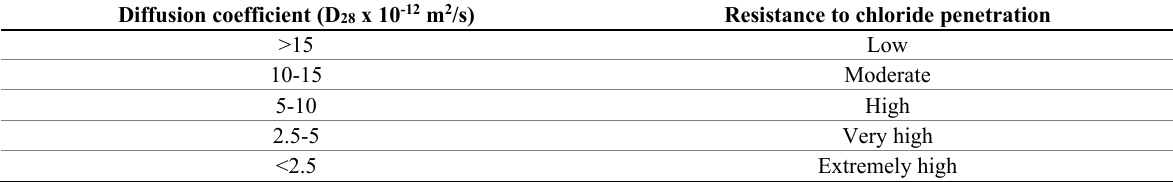
Table 5. Classification according to resistance to chloride penetration Diffusion coefficient (D 28 x 10 -12 m 2 /s)